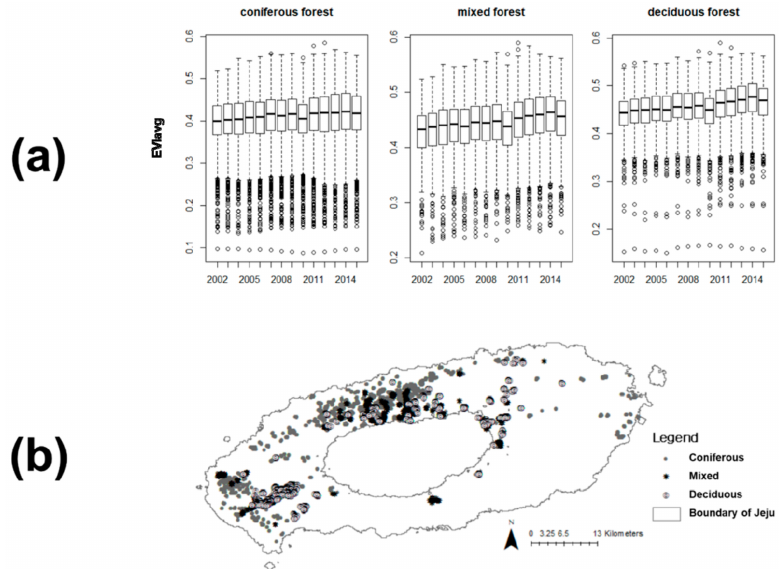
Figure 3. Temporal changes in annual average EVI (EVIavg) from 2002 to 2015. ( a ) The figure shows the range of EVIavg in the growing season (March–October) from 2002 to 2015. ( b ) The points indicate a decrease in EVIavg in 2015 compared with 2002. It shows the locations of negative value, when we calculate ‘EVIavg in 2015 (cid:48) minus ‘EVIavg in 2002 (cid:48)